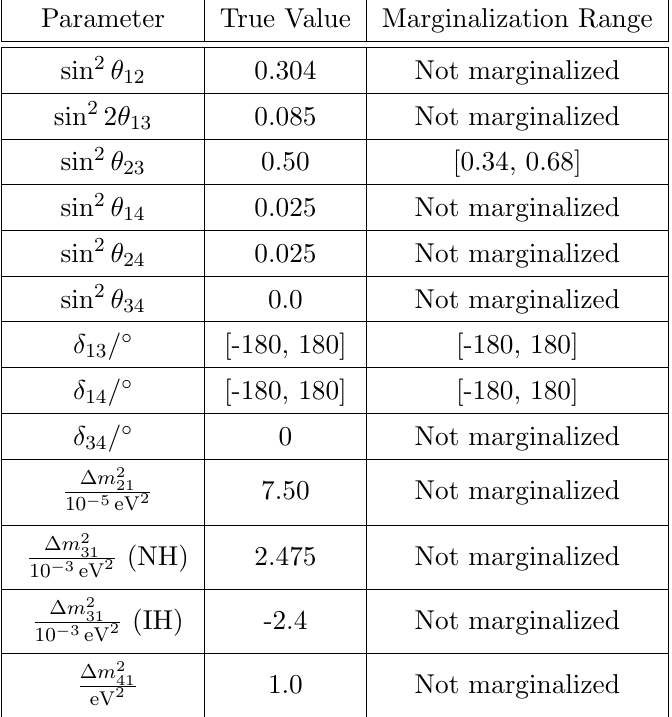
Table 1 . Oscillation parameters considered in our analysis. The second column depicts the true values of the oscillation parameters used to simulate the \observed" data set. The third column shows the ranges over which sin 2 (cid:18) 23 , (cid:14) 13 , and (cid:14) 14 are varied while minimizing the (cid:31) 2 to produce the (cid:12)nal